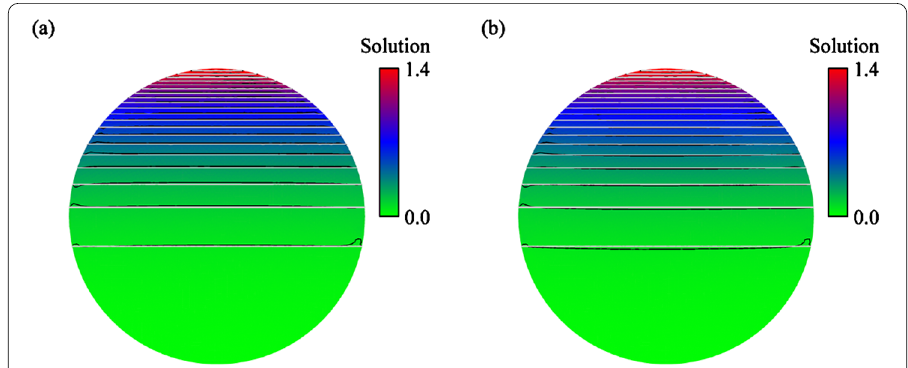
Figure 6 Comparisons of the numerical and exact solutions for Test 3. The results with (a) FU scheme and (b) IS scheme. The contour lines for u = 0.05 n where n represent non-negative integers are depicted: black lines are for numerical solution and grey lines for exact solutions.